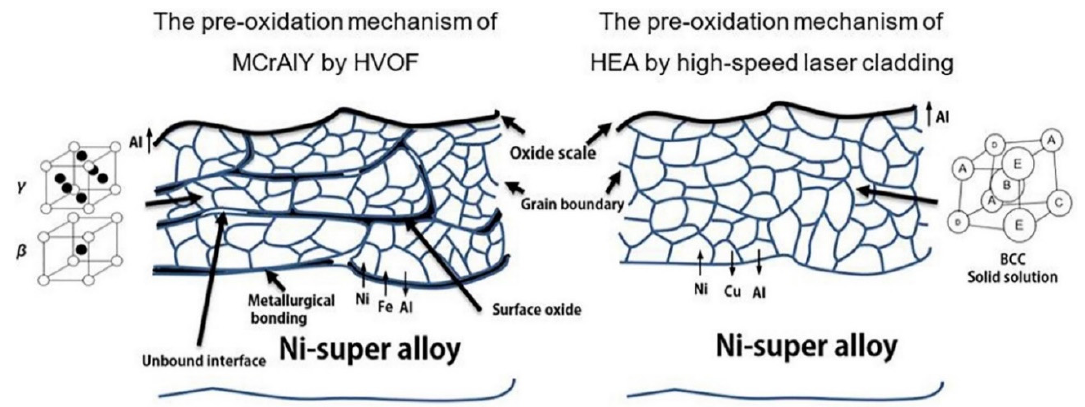
Figure 4. Shows difference of pre-oxidation between HVOF-deposited conventional MCrAlY and high-speed laser -cladded HEA coating. The blocking effect to the continuous depletion of Al element in lamellar structure in the thermal-sprayed coating is due to the unbound interface, surface oxide and partial metallurgical bonding. Reprinted with permission from [97] Copyright 2020 Elsevier.